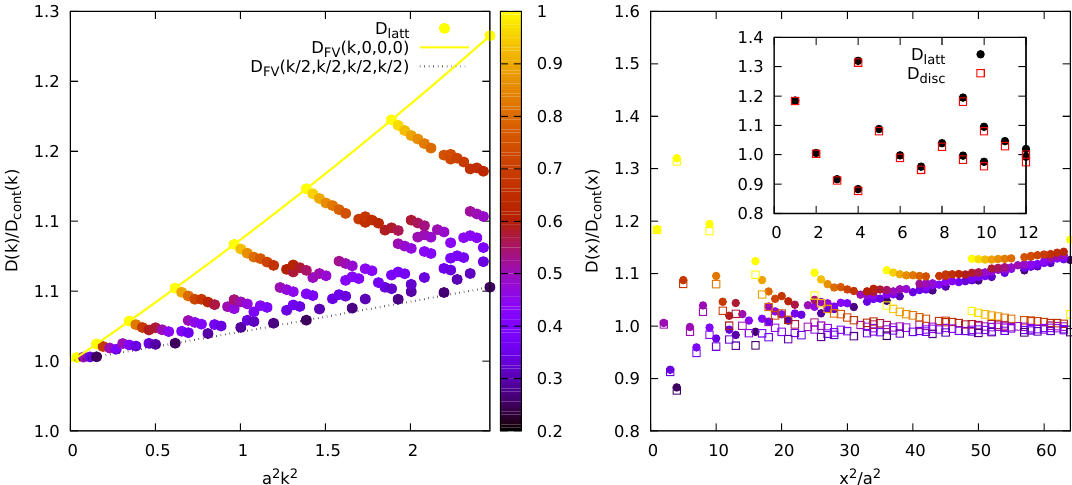
Figure 1. Ratio of the lattice Klein-Gordon propagator D latt for N = 32 and aµ = 0 . 1 and its continuum counterpart D in momentum (left) and position (right) space. In momentum-space, cont full lines have been added for the ratio D for the two limiting cases of orbit along an FV /D cont axis and along the diagonal. In position-space, empty symbols represent the ratio D disc /D cont corresponding to an infinite volume lattice (the inset shows how the short-distance behavior is almost identical in the finite and infinite volume cases). In both plots, the color map corresponds to the dimensionless ratio n [4] / ( n 2 · n 2 )